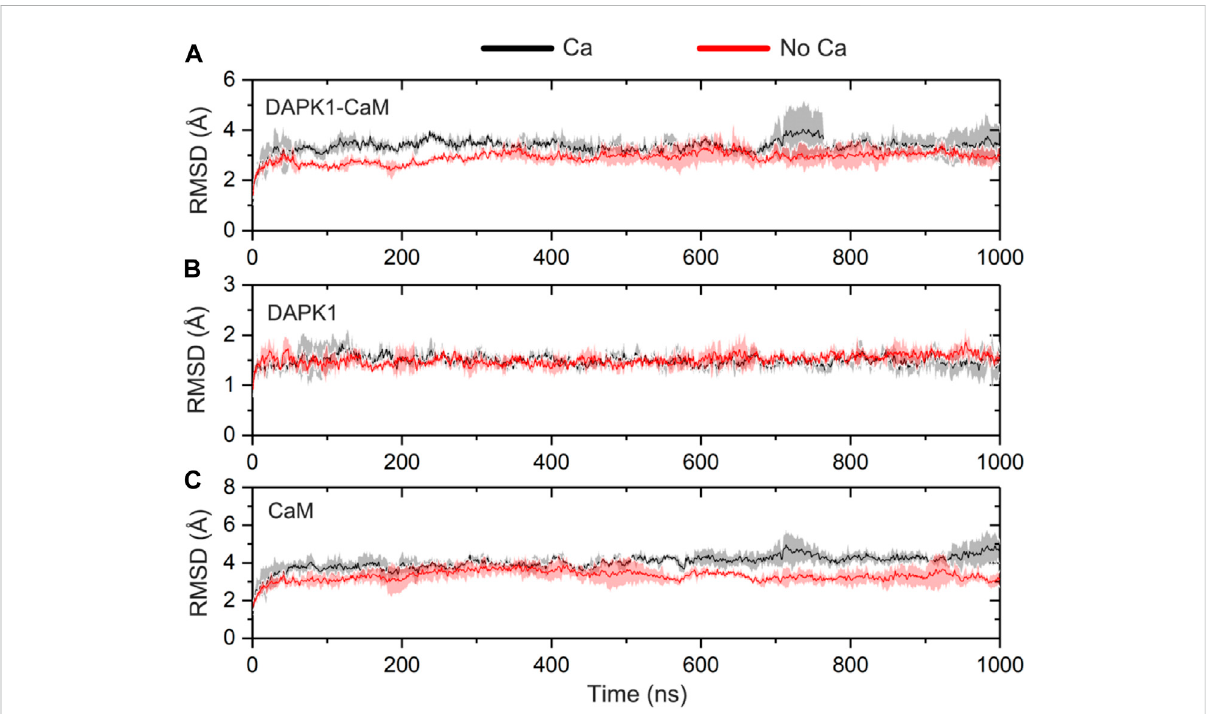
Time-dependent root-mean-square deviation (RMSD) of the C α atoms for the DAPK1 − CaM complex (A) , the independent DAPK1 (B) and CaM (C) in the three independent runs in the presence (black) and absence (red) of Ca 2+ . Transparent shades mean standard